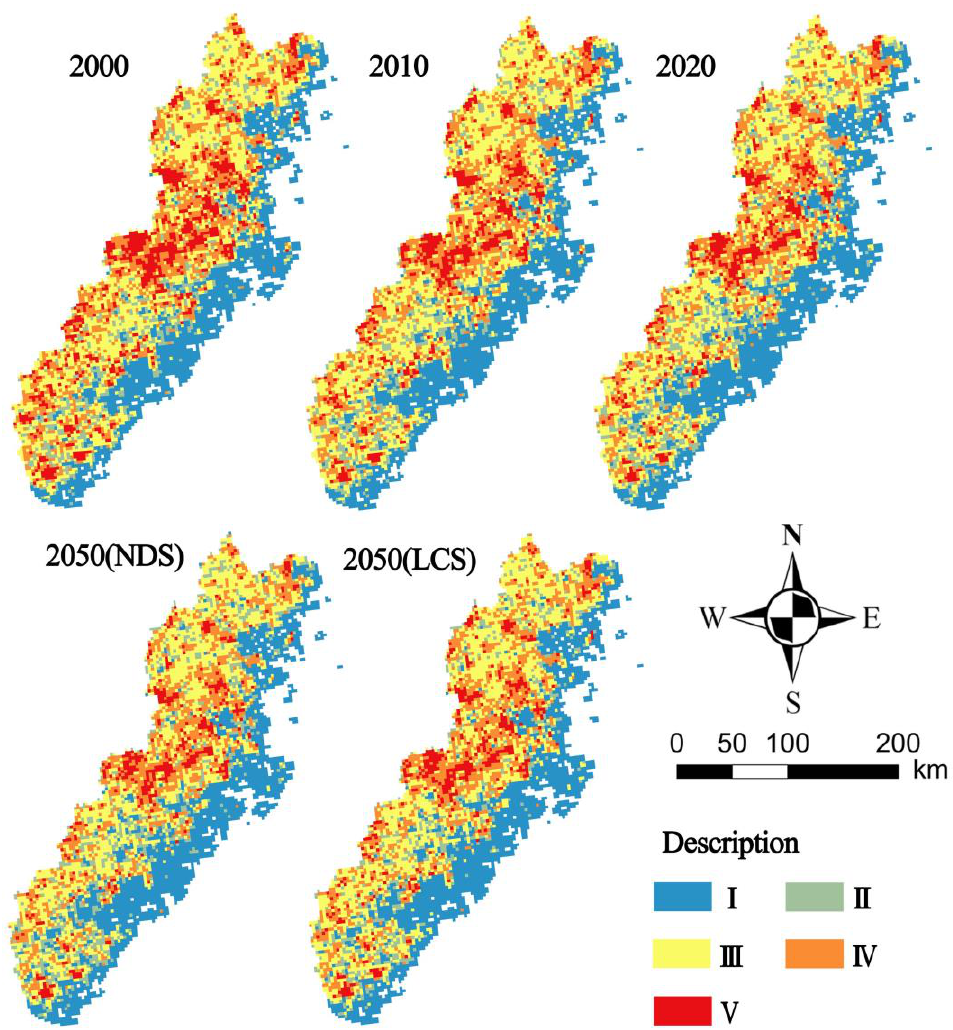
Figure 8. Spatial distribution map of total ESV variation in coastal areas of Fujian from 2000 to 2050. NDS: natural development scenario; LCS: low-carbon scenario.